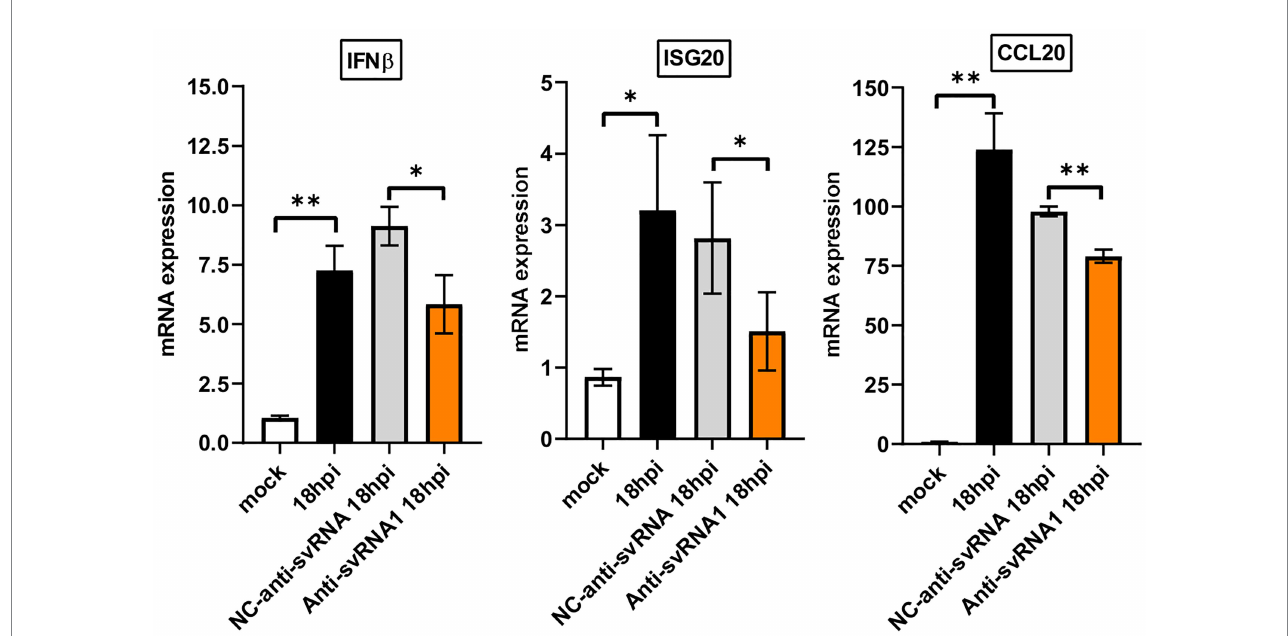
FIGURE 9 Expression levels of IFN β , ISG20, and CCL20 mRNAs in Vero E6 cells treated or not with anti-sense molecules for svRNA 1. Vero E6 cells were mock transfected or transfected with either a specific antisense oligonucleotide for svRNA 1 (Anti-svRNA1) or an irrelevant oligonucleotide (NC-anti-svRNA) as a negative control. At 36 h post-transfection the cells were infected with SARS-CoV-2 (1 PFU/cell) and the levels of IFN β , ISG20 and CCL20 mRNAs were analyzed at 18 hpi by RT-qPCR. The ΔΔ Ct method was used for relative quantification with RPP30 mRNA as an endogenous control. Data are represented as fold change relative to non-transfected mock-infected (mock) cells and are the mean ± SD of at least three independent experiments. Differences from control values were found to be statistically significant at * p < 0.05 and ** p <